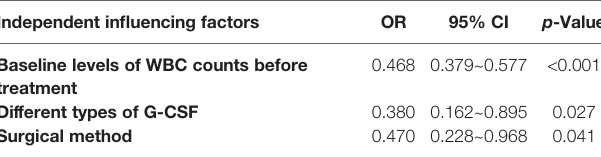
TABLE 4 | Multivariate logistic regression model estimates of independent in fl uencing factors for leukopenia in the 12th month after the end of the last chemotherapy.